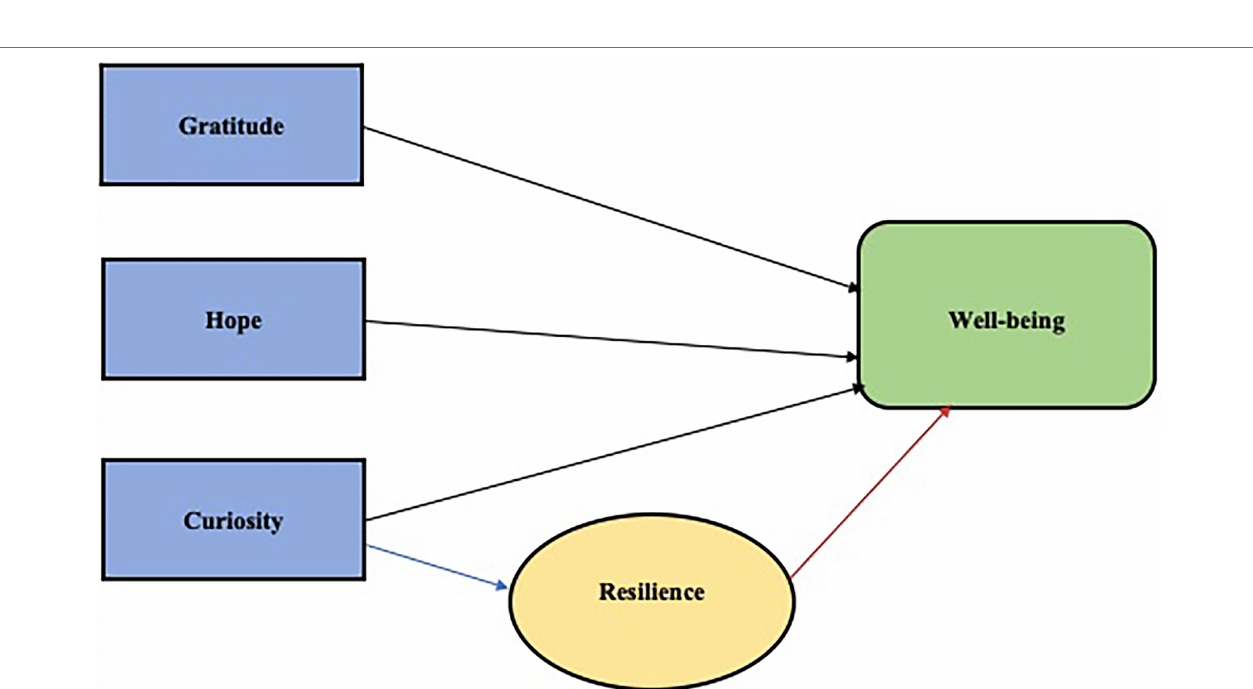
FIGURE 2 | A graphical illustration of a simplified version of the reduced model presented to the panel of practicing